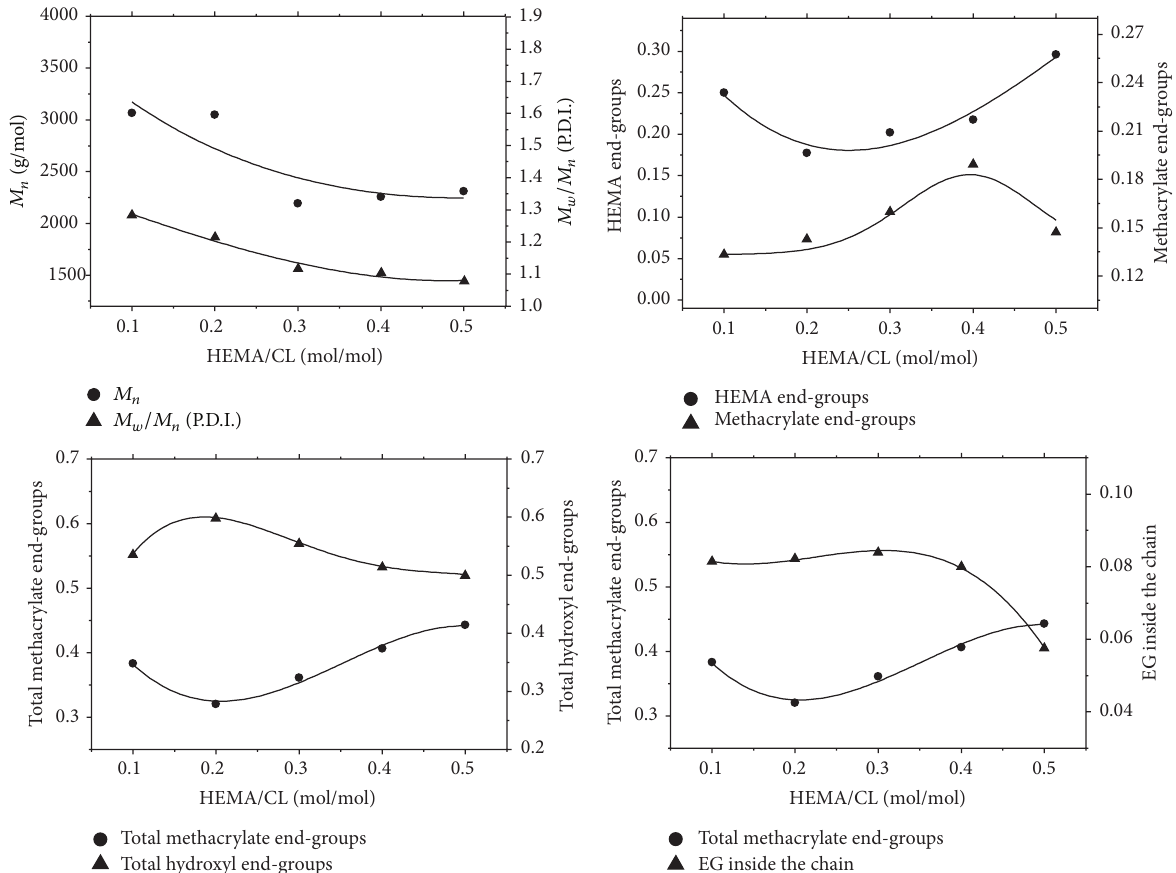
Figure 6: The effect of HEMA/CL on 𝑀 𝑛 , polydispersity, HEMA, methacrylate, total methacrylate, hydroxyl end-groups, and EG inside the chains (Synthesis at 70 ∘ C, 6 hours, 100 mg Novozyme-435, and 9/45 (mmole/mmole) of HEMA/CL).